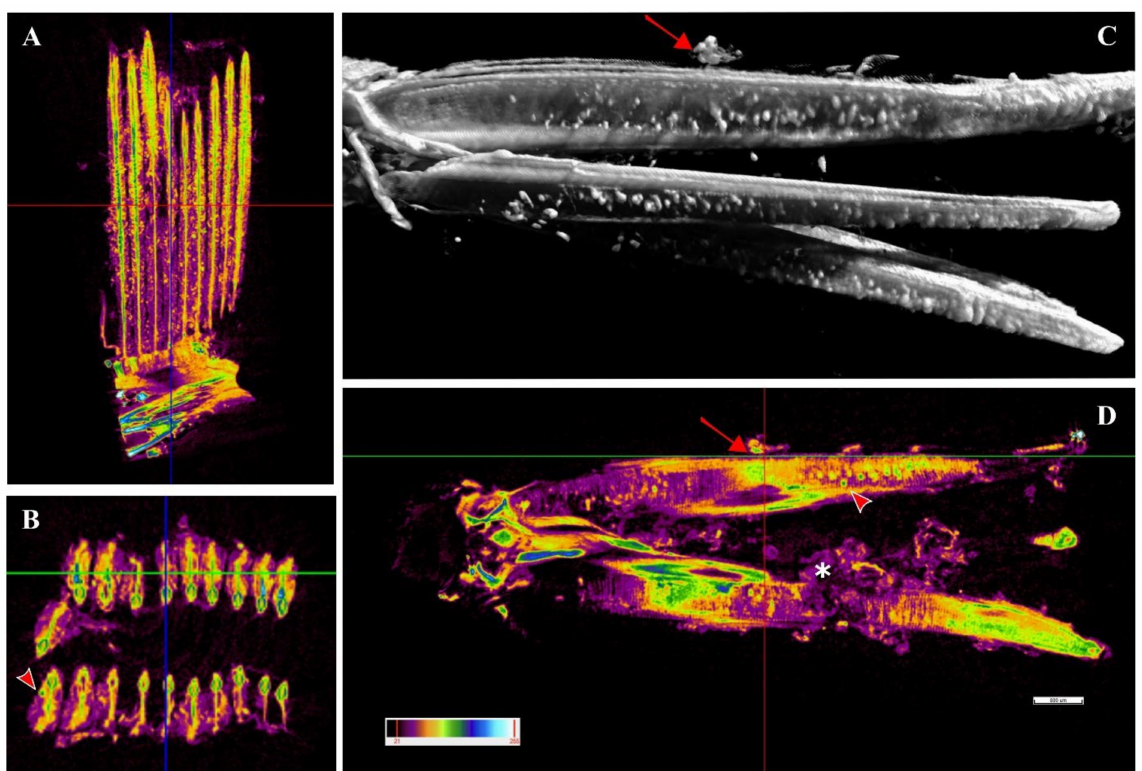
Figure 8. X-ray micro-computed tomography of greater amberjack infected gills (September 2018). ( A , B , D ) Two-dimensional cross sections of a partial gill arch seen along three different axes. Density of tissue is displayed with a range of colours from black to white. Denser structures are in white, blue and green. ( C ) Three-dimensional volume rendering of three filaments. Cysts are seen as yellow spherical structures between the secondary lamellae and when the section cuts through them they display a green (denser) colour (arrowheads). Proliferative epithelial tissue is also seen outside and between the filaments (asterisk) and, when density-inspected, the presence of cysts is revealed